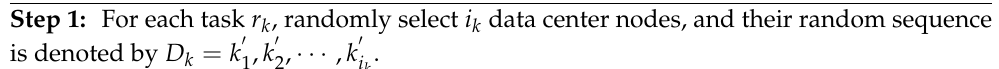
Algorithm 5 Strategy for generating path variable x